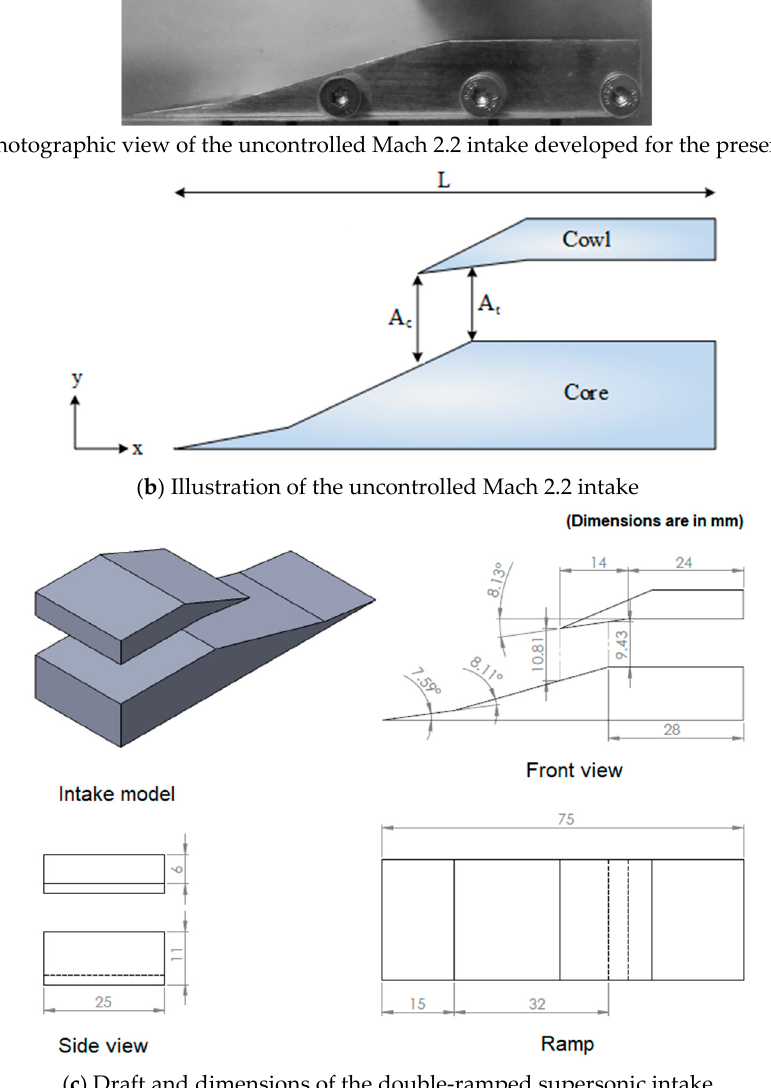
Figure 3. Mixed-compression intake at Mach 2.2 with specifications.